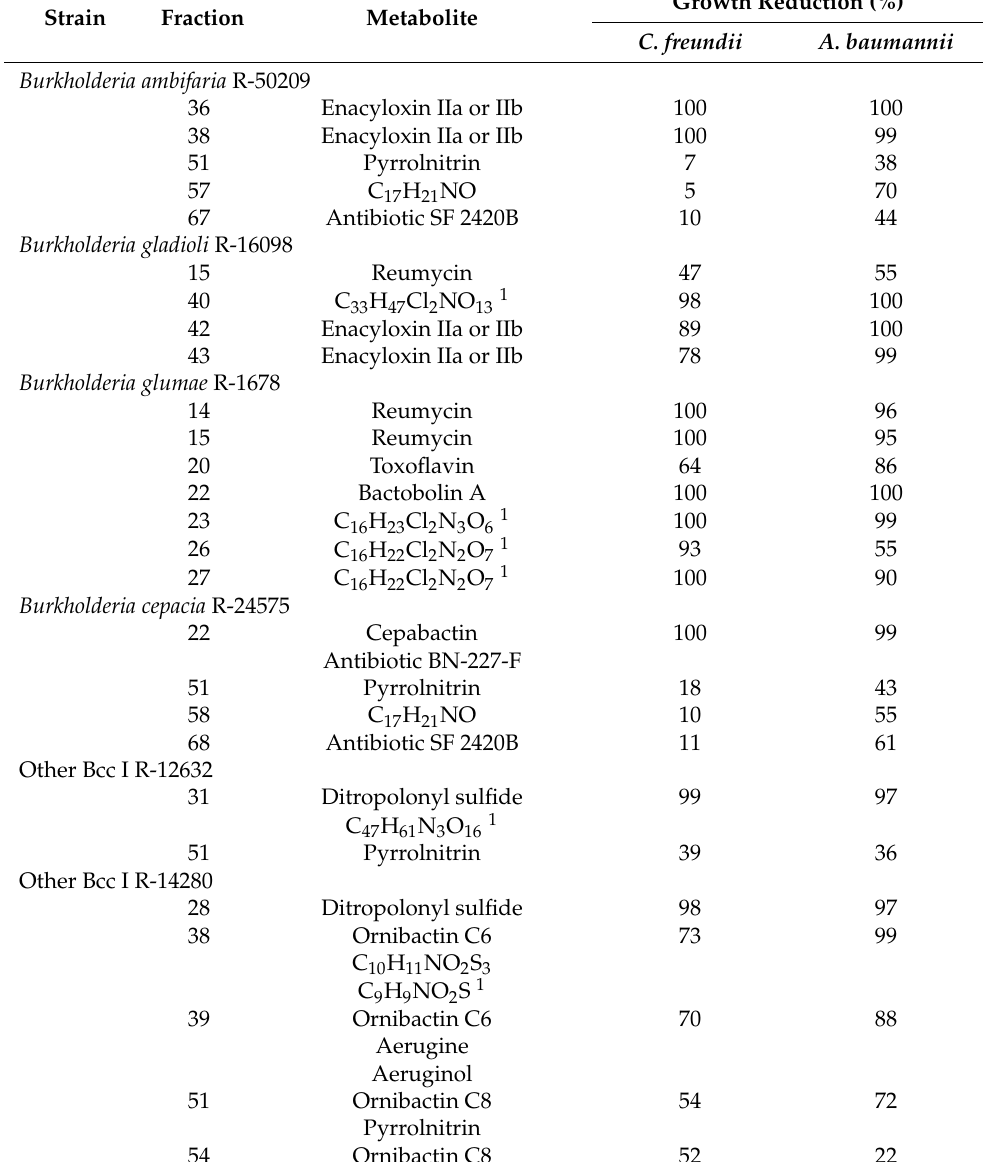
Table 4. Specialized metabolites detected in active fractions of six Burkholderia isolates. Crude agar extracts were subjected to semipreparative fractionation and tested for antimicrobial activity against Citrobacter freundii R-67508 and Acinetobacter baumannii LMG 10520. Metabolites present within active fractions resulting in ≥ 40% growth reduction of at least one of the two pathogens were identified using